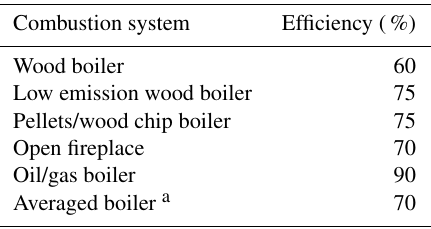
Table A2. Efficiency of boilers and fireplaces used in emission in- ventory (Omstedt et al., 2014; Andersson et al.,